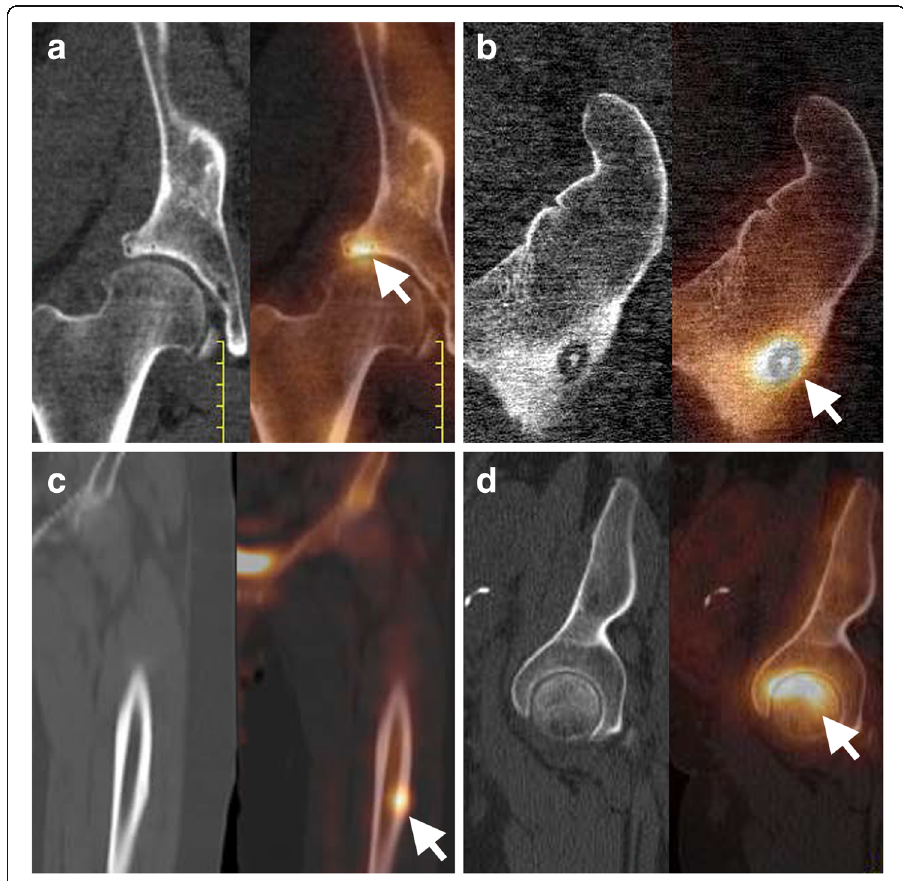
Fig. 2 Bone SPECT/CT imaging of the painful hip. Illustration of bone SPECT/CT applications in imaging the painful hip. a femoro-acetabular impingement of the right hip, b subtrochanteric osteoid osteoma of the left femur, c chronic bisphosphonate use induced stress fracture of the left femur, and d avascular necrosis of the femoral head (reparative